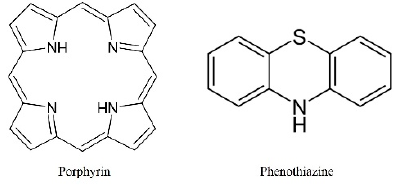
Figure 4. Typical structure of photosensitizing agents (PS). Photofrin® and 5-amiolevulinic acid are typical examples of porphyrin-based PS, while toluidine blue and methylene blue are typical examples of phenothiazine-based PS.